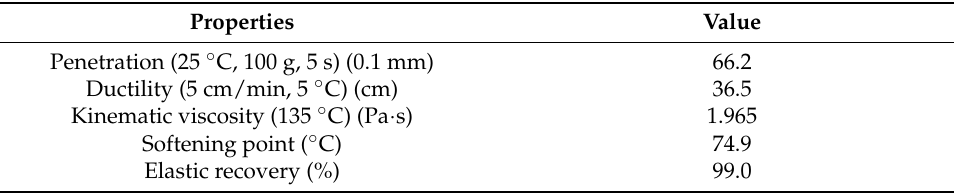
Table 2. Properties of SBS modified asphalt.